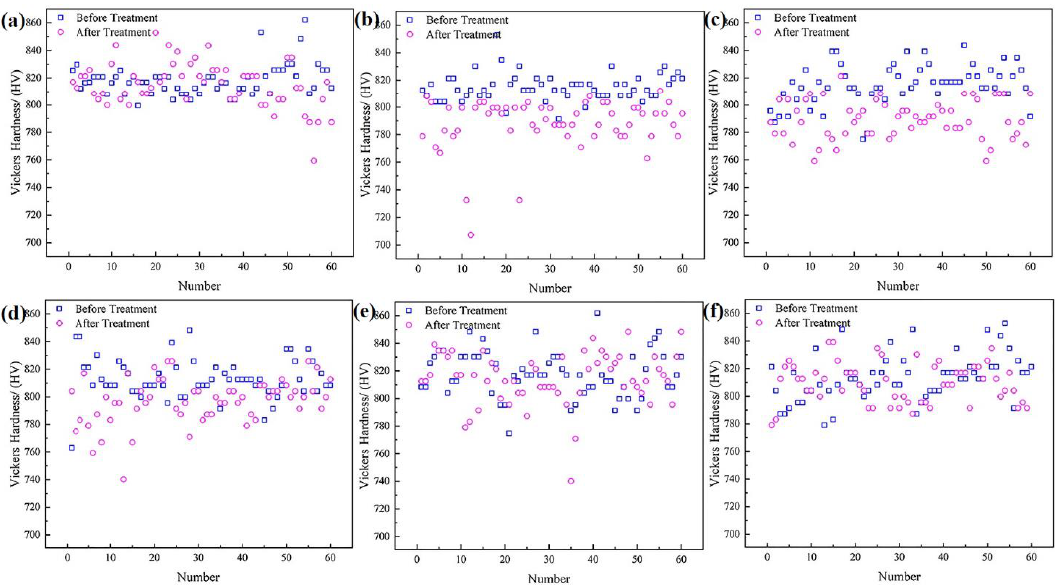
Figure 9. Vickers hardness before and after treatment at different magnetic fields. ( a ) 0 T; ( b ) 1.0 T; ( c ) 1.3 T; ( d ) 1.5 T; ( e ) 2.0 T; ( f ) 2.5 T.